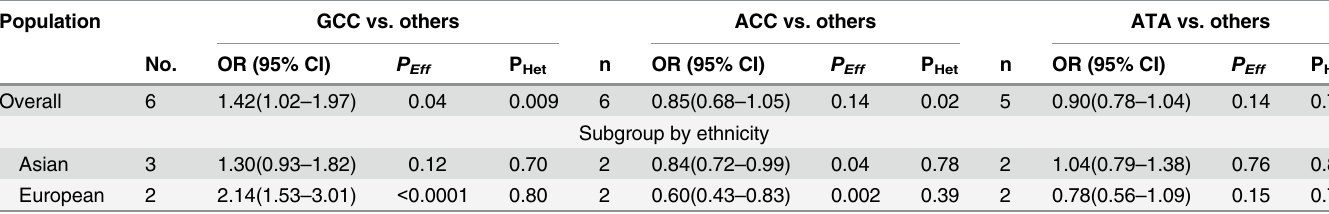
Table 6. Meta-analysis of the association between IL-10 promoter haplotype (-1082G/A, 819C/T, 592A/C) and TB. Population GCC vs.